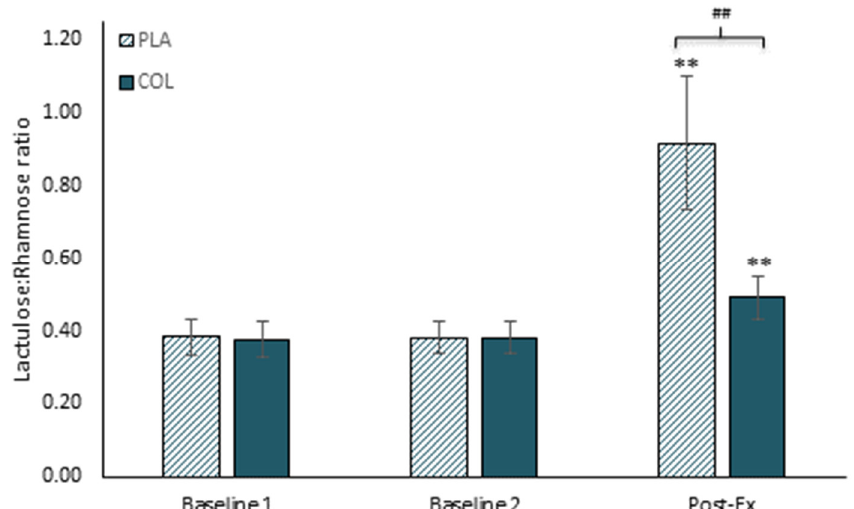
Figure 1. Gut permeability from Marchbank et al. [20] by 5 h urine collection. Dual sugar probe test: 5 h urine collection after ingestion of lactulose and rhamnose. Baseline measurements taken at rest and Post-Ex (post-exercise) measures taken after 20 min running at 80% VO 2 max following 2 weeks of placebo (PLA) or colostrum (COL) supplementation. ** p < 0.01 compared with baseline (rest); ## p < 0.01 colostrum compared with placebo.